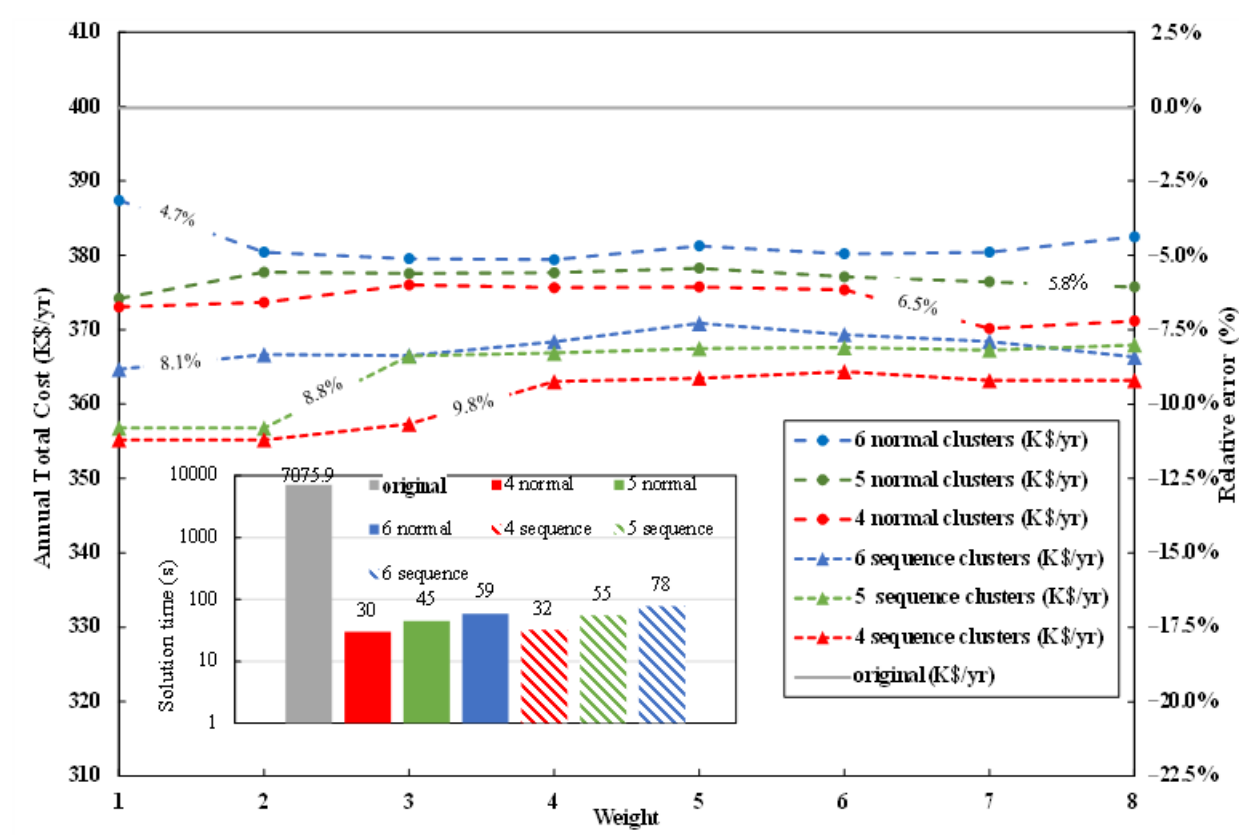
Figure 7. Comparison between original and clustered energy hub solutions in terms of solution quality and time.